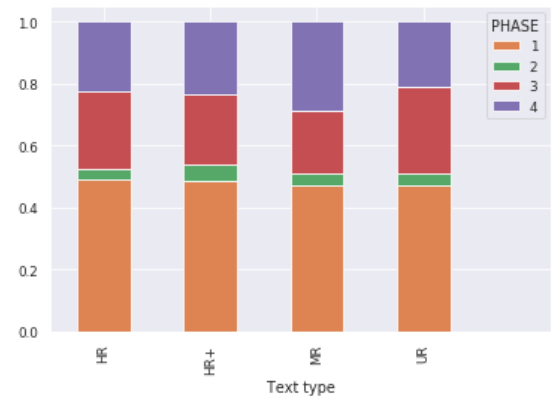
Figure 5. Phase sample distribution per extended text type.